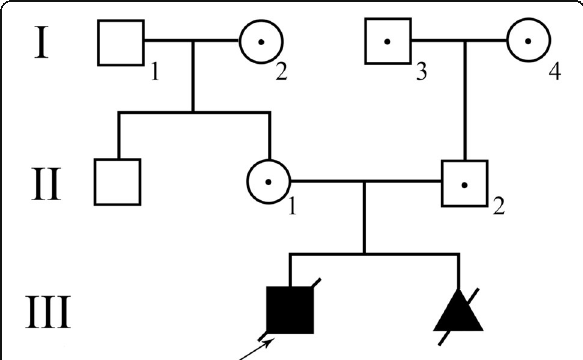
Fig. 1 Pedigree structure of the family participating in this study. Affected members are indicated with filled symbols, and unaffected relatives are indicated by open symbols, whereas heterozygous carriers are indicated with a dot in the middle of the symbols. Numbers are allotted to the family members whose DNA samples were used in this study. The proband is indicated with an